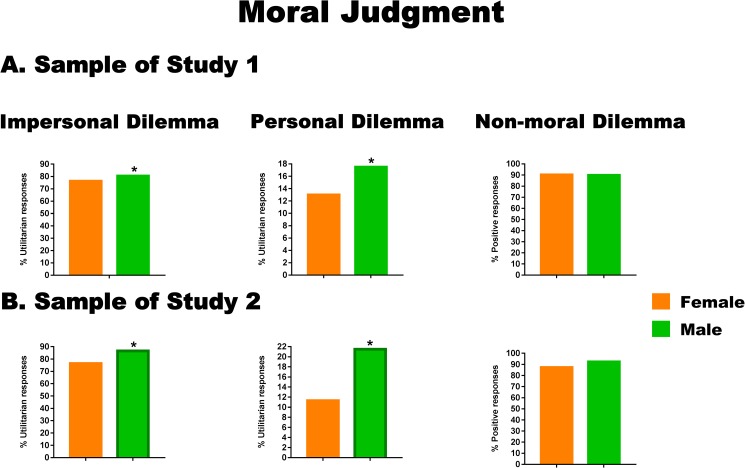
Significant sex differences in responses to moral and non-moral dilemmas.Asterisks indicate significant differences (p < .05). Differences with a small or higher effect size (Cramer’s V ≥ 0.1) are marked with a bold border.